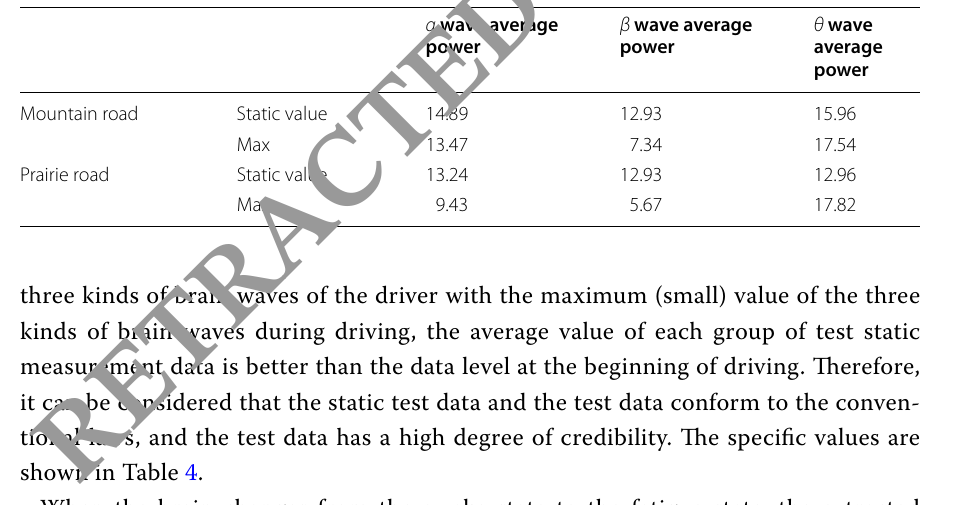
Table 4 Static measurement values of EEG indicators and various indicator values during